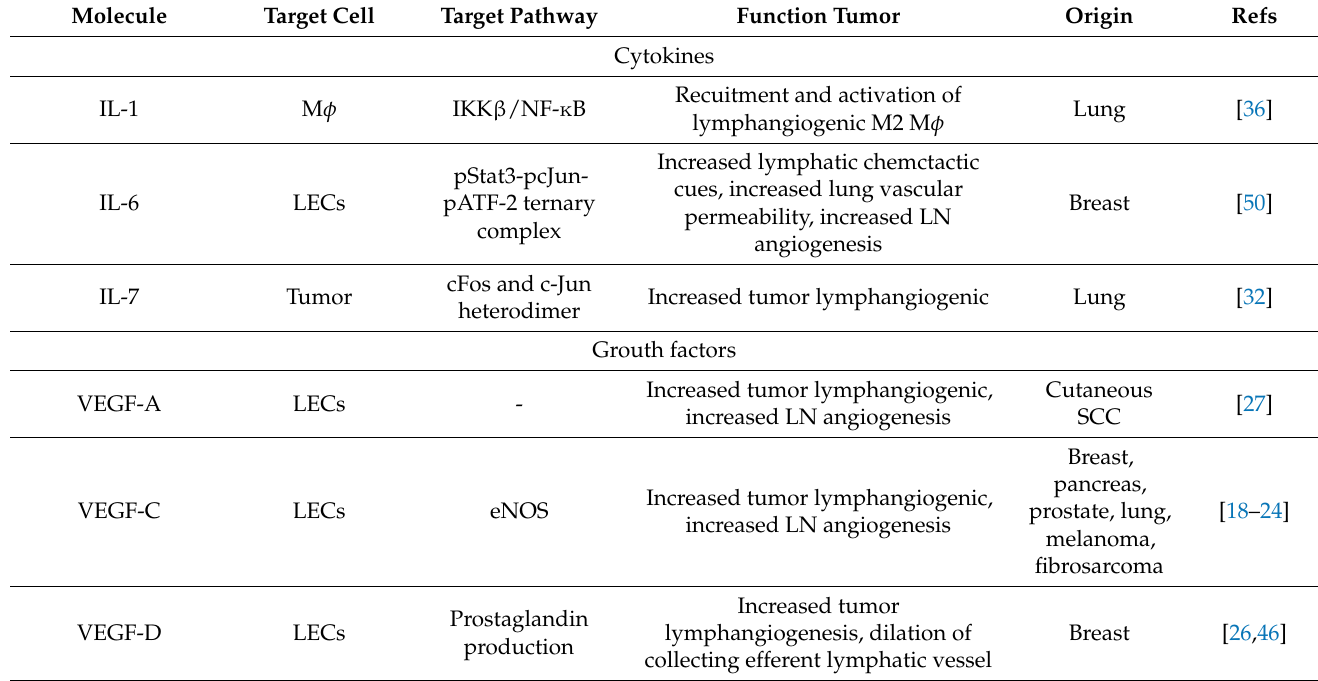
Table 1. Summary of tumor-secreted molecules affecting lymphatic